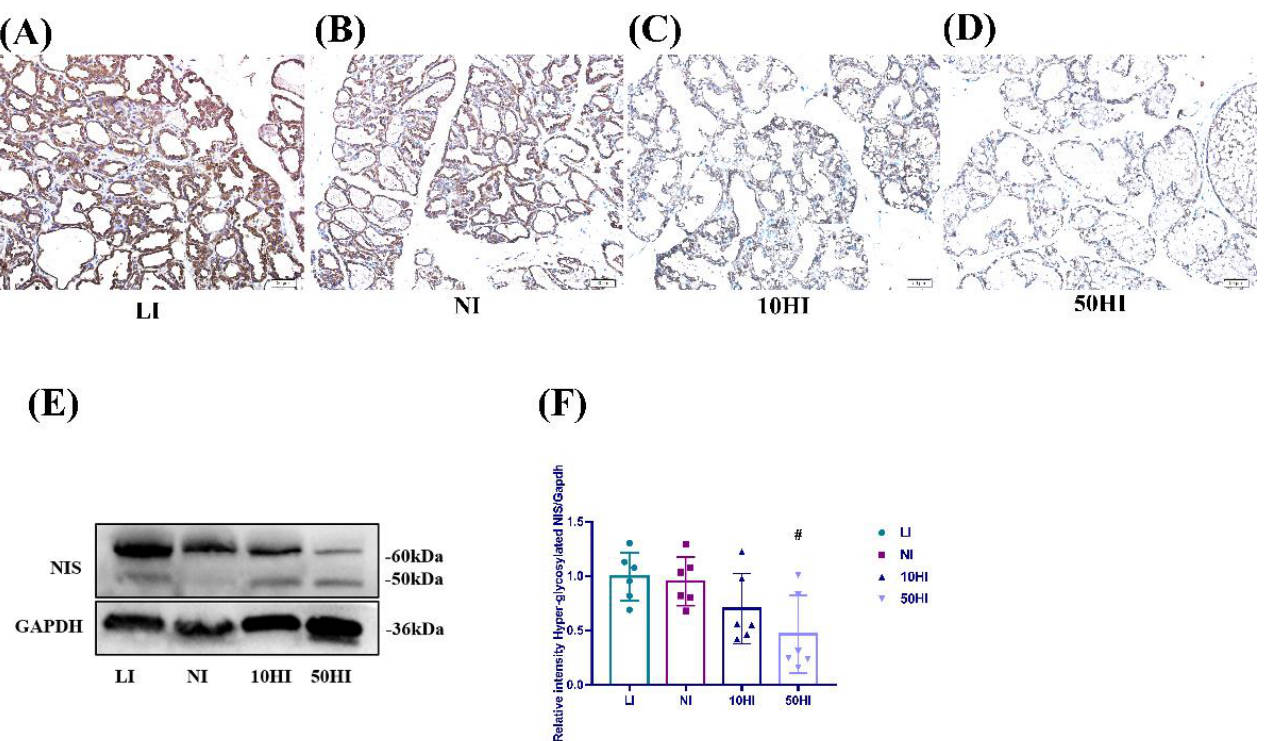
Figure 3. ( A − D ) Localization of NIS in the mammary gland on the 14th day of lactation. Scale bars: 50 µ m. ( E ) Representative immunoblots of NIS. ( F ) Bar graphs show the semiquantitative levels of Hyperglycosylated NIS determined by band density analysis. (Values are shown as means ± SD. n = 6 per group. Comparisons among different groups were performed by one − way ANOVA and followed by an LSD test for multiple comparisons. # p < 0.05 compared with the NI group.)